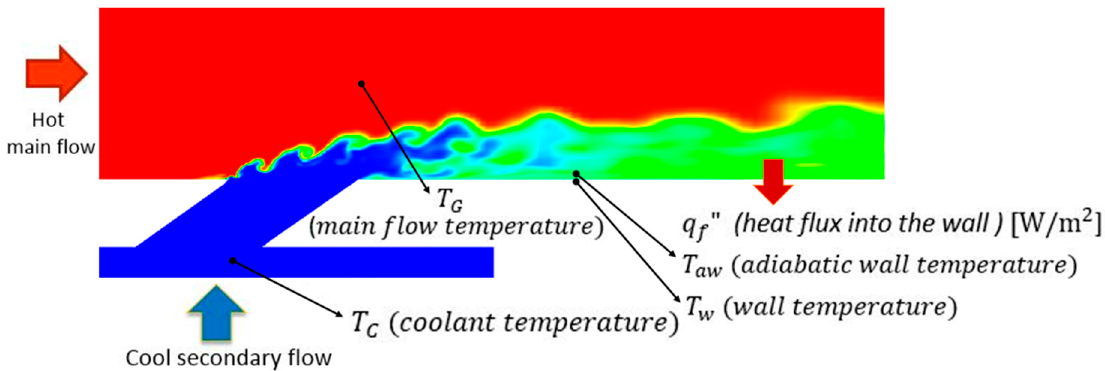
Figure 3. The temperature contours showing the coolant distribution of film cooling (Side view).